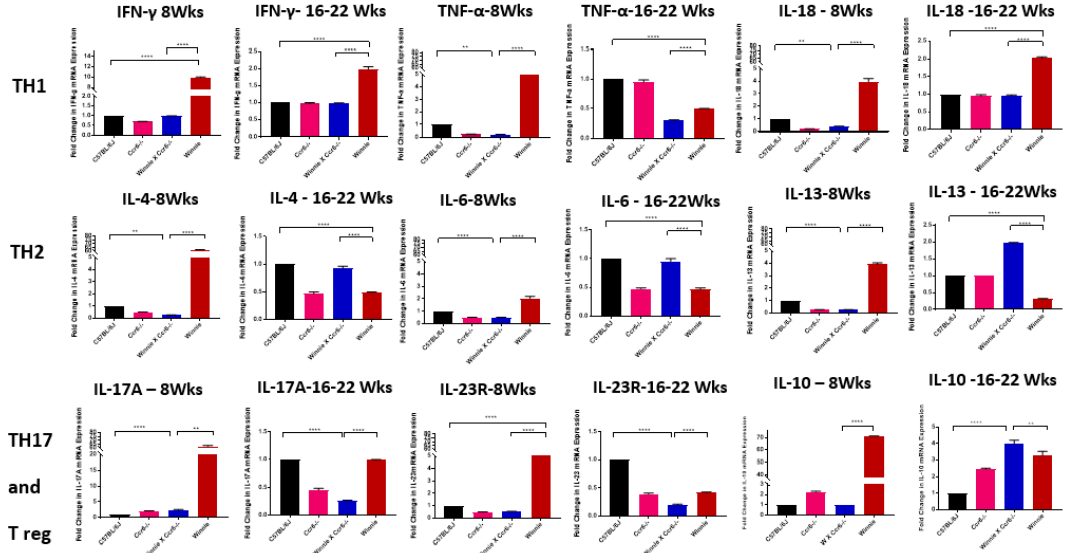
Figure 10. Fold change in mRNA expression of IFN-g, TNF- α , IL-18, IL-4, IL-6, IL-13, IL-17A, IL-23R, IL-10 at 8 weeks and 16–22 weeks. Cycle of threshold (CT) values were normalised to Gapdh and CT calculated using the method of 2 − ∆ CT . Data expressed as Mean ± SEM by One- way analysis of variance (ANOVA) and Tukey’s multiple comparison test, n = 6 per group. ** p < 0.01, **** p < 0.0001.